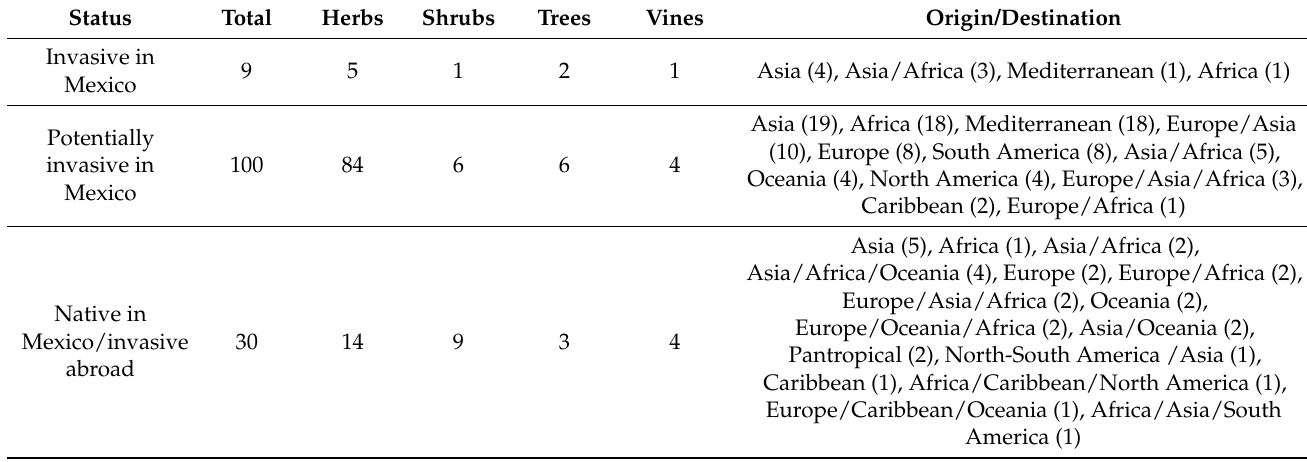
Table 2. Mexican coastal dunes: donors and recipients of invasive flora. In parenthesis, the number of species in each region. When the origin included different regions, they were listed in each, thus, numbers in parenthesis may add more than the total.